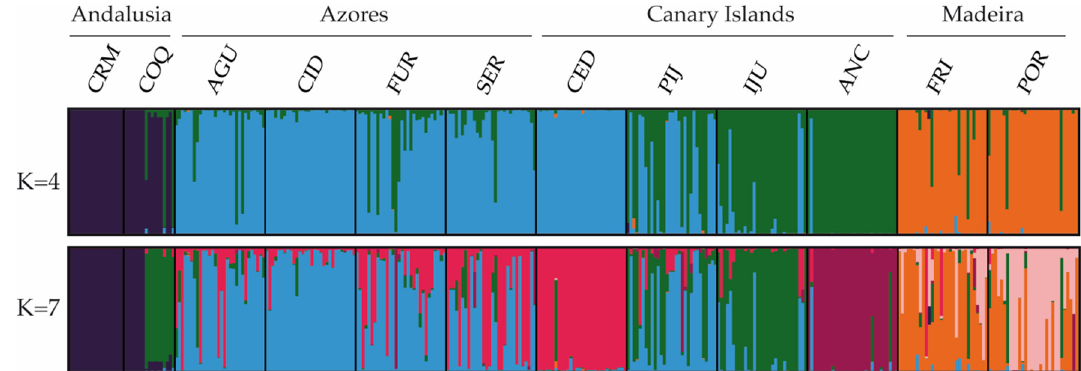
Figure 2. Estimated genetic structure based on microsatellite data using the Bayesian approach implemented in STRUCTURE. Histograms of individual assignment to clusters show the two most probable structuring, K = 4 and K = 7.